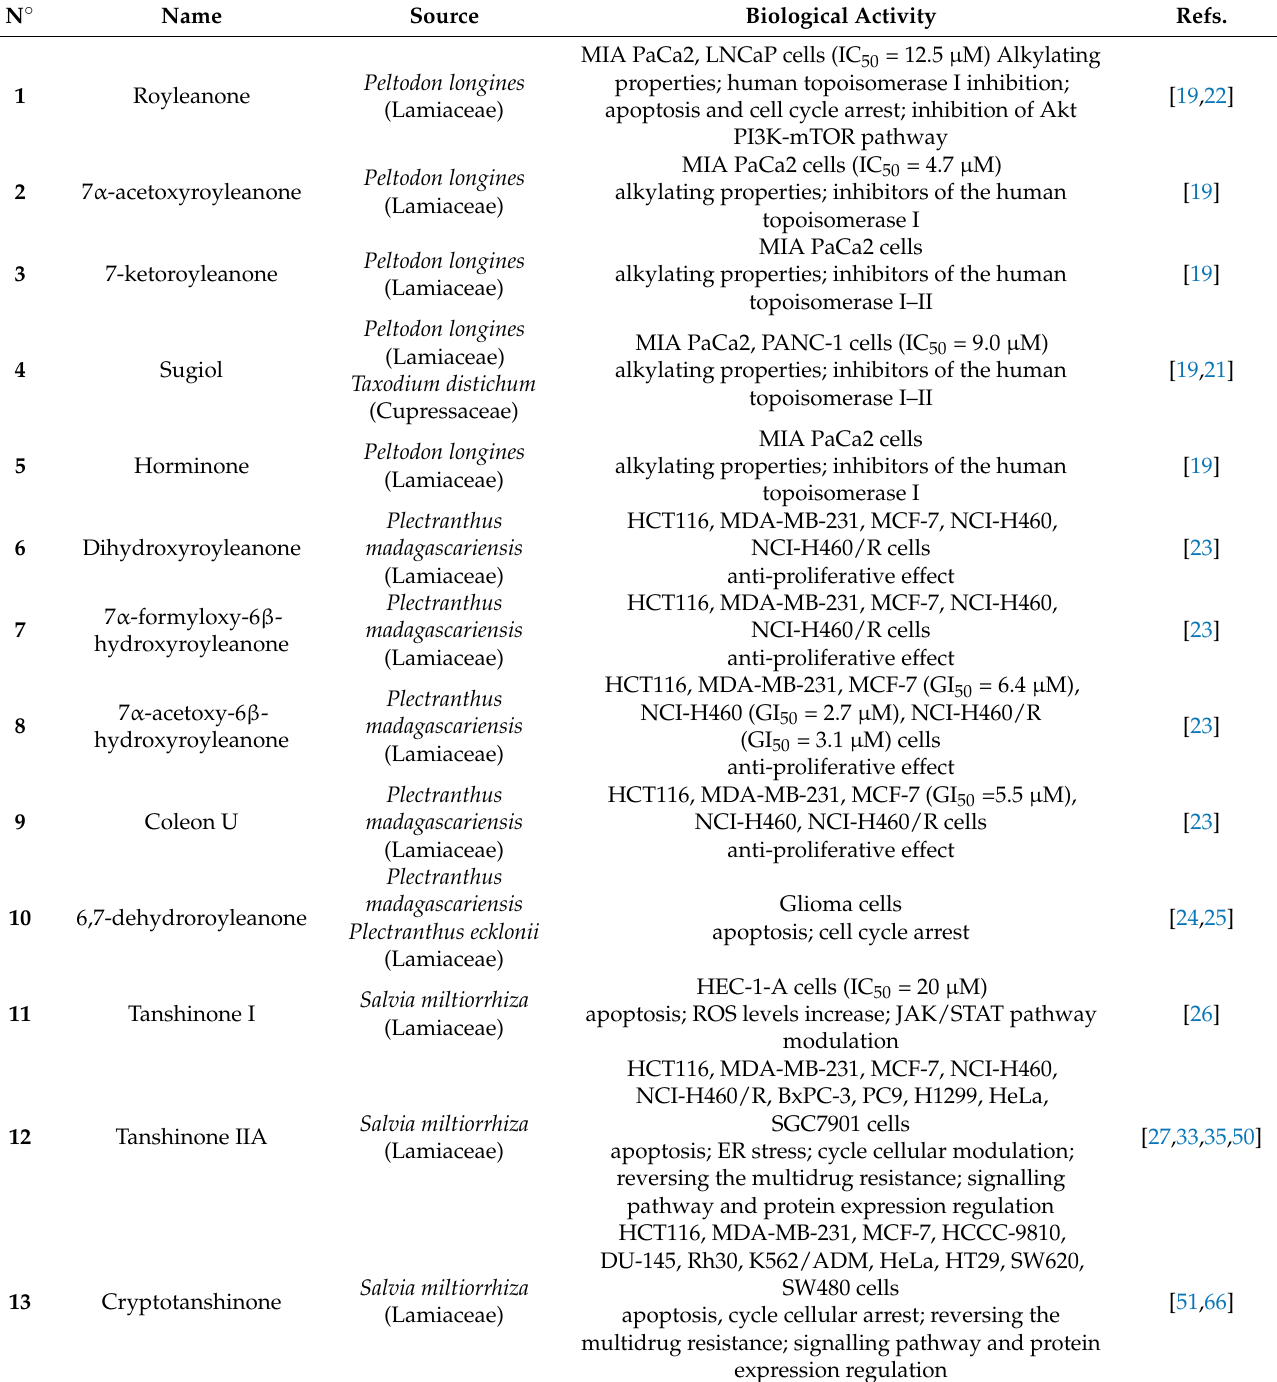
Table 1. Sources and biological activities on cancer cell lines of abietane